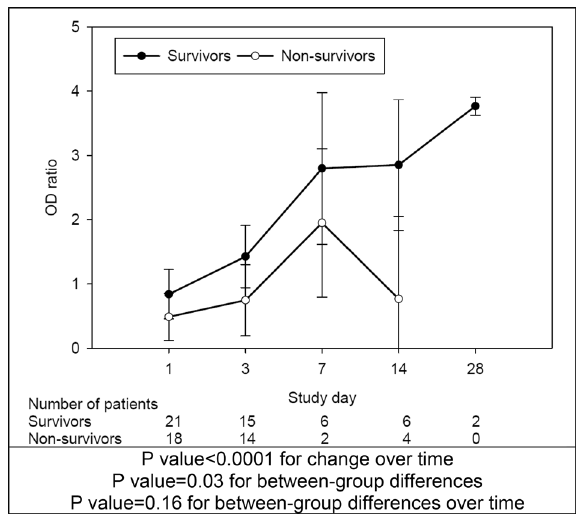
Figure 1. The antibody (IgG) response to Middle East respiratory syndrome (MERS) coronavirus among critically ill patients. Results are expressed as optical density ratio (OD ratio). To account for the fact that repeat antibody testing was not performed after ICU discharge, we carried forward the OD ratio up to day 28 or death whichever came first. Box plots are displayed for the ranks with medians and quartiles 1 and 3. The error bars refer to